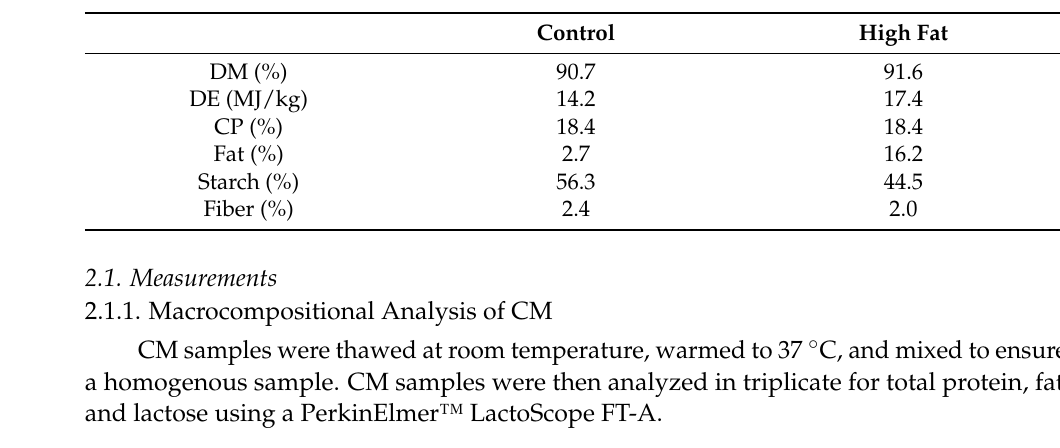
Table 1. Nutrient content of the control and high fat diets fed to growing